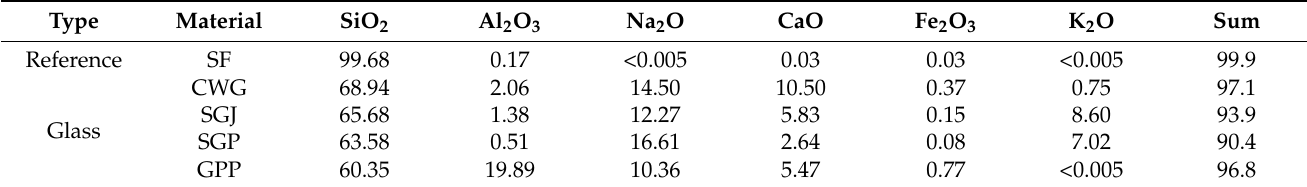
Table 3. Chemical analysis of glass powder on the basis of X-ray fluorescence. All values are expressed as